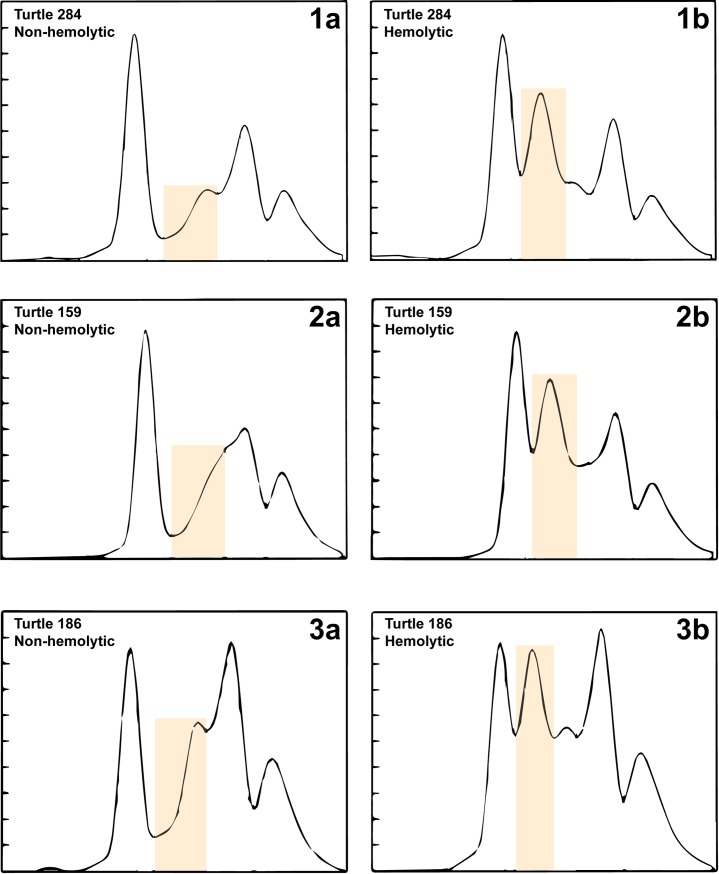
Electrophoretograms of three individual nesting leatherback sea turtles (Dermochelys coriacea) without (left column) and with (right column) hemolysis showing a prominent alpha2-globulin fractions as highlighted in orange in hemolyzed samples. The orange boxes serve to highlight the alpha2-globulin fraction.